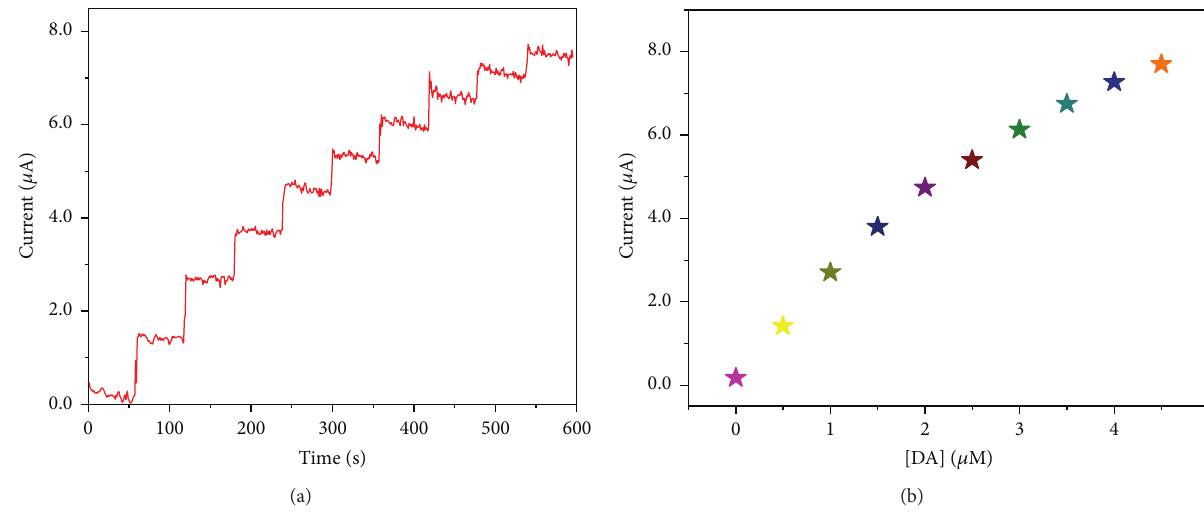
Figure 12: (a) Chronoamperometric I-T curve obtained for 𝛼 -Fe 2 O 3 nanoparticle-modified electrode during successive addition of 0.5 𝜇 M of DA in 0.1M PBS (pH = 6.8) at applied potential of 200 mV. (b) The calibration curve obtained upon the 0.5 𝜇 M addition of DA in 0.1M PBS (pH = 6.8).